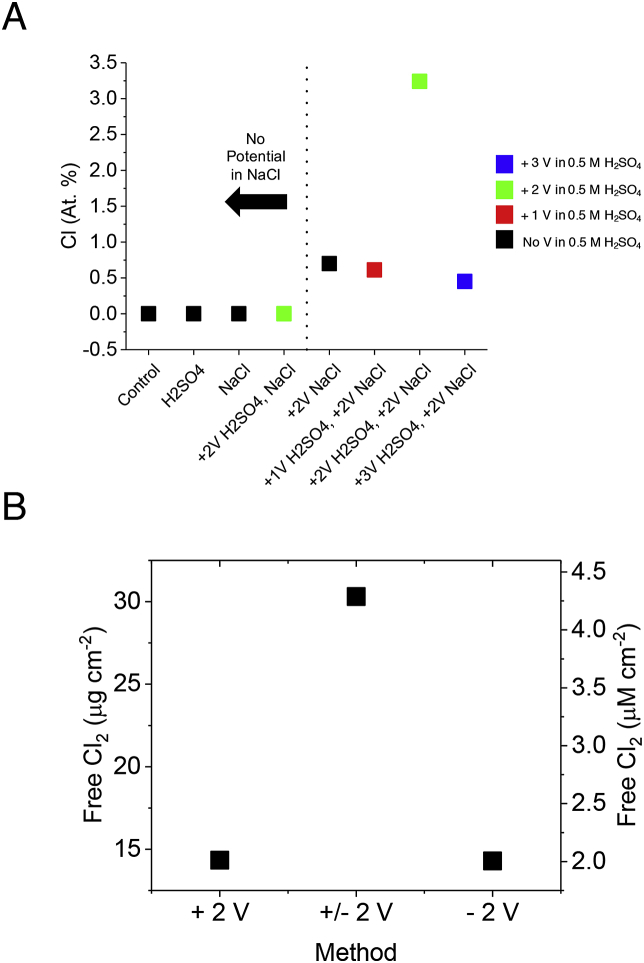
A) Chlorine containing species (CCS) adsorbed on BD-UNCD electrodes as a function of pre-treatment conditions. Where no voltage is indicated, the electrode was left in the indicated electrolyte without bias for the same amount of time as those electrodes that were polarized (20 min in 0.5 M H2SO4 and 45 min in 0.154 NaCl). The color of each point indicates the magnitude of anodic polarization in 0.5 M H2SO4. B) Free chlorine generation versus treatment method after 45 min electrolysis in 0.154 M NaCl.